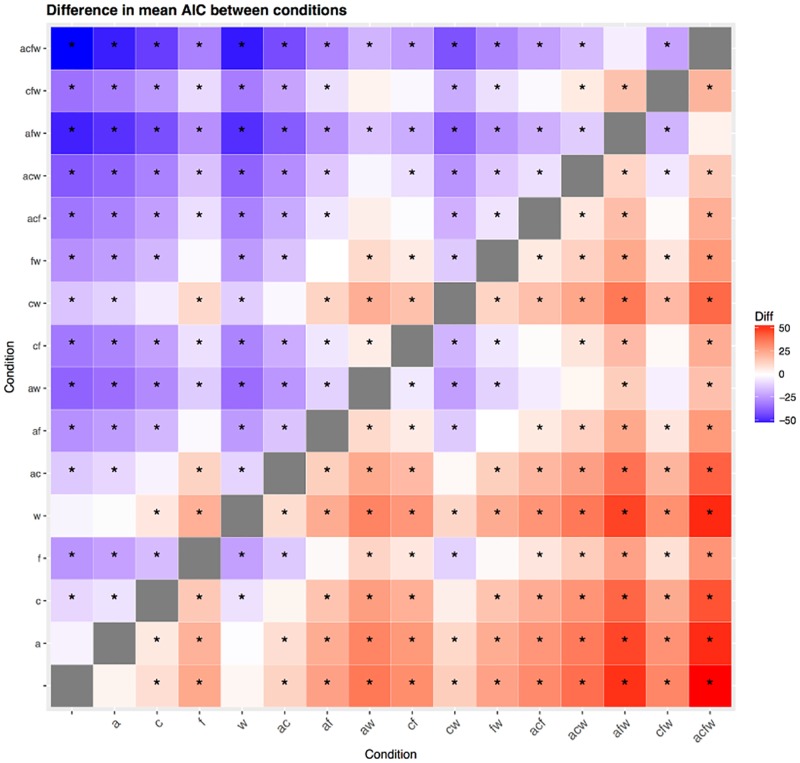
Difference in AIC between conditions.This symmetric matrix represents the difference in Akaike’s Information Criterion (AIC) between all pairs of conditions (same conventions as in Fig 15) as color, varying between no difference (white) and maximum difference (positive red, negative blue); a star * means that the cell represents a significant difference in AIC between the two conditions (i.e., the difference is bigger than 5 AIC points).